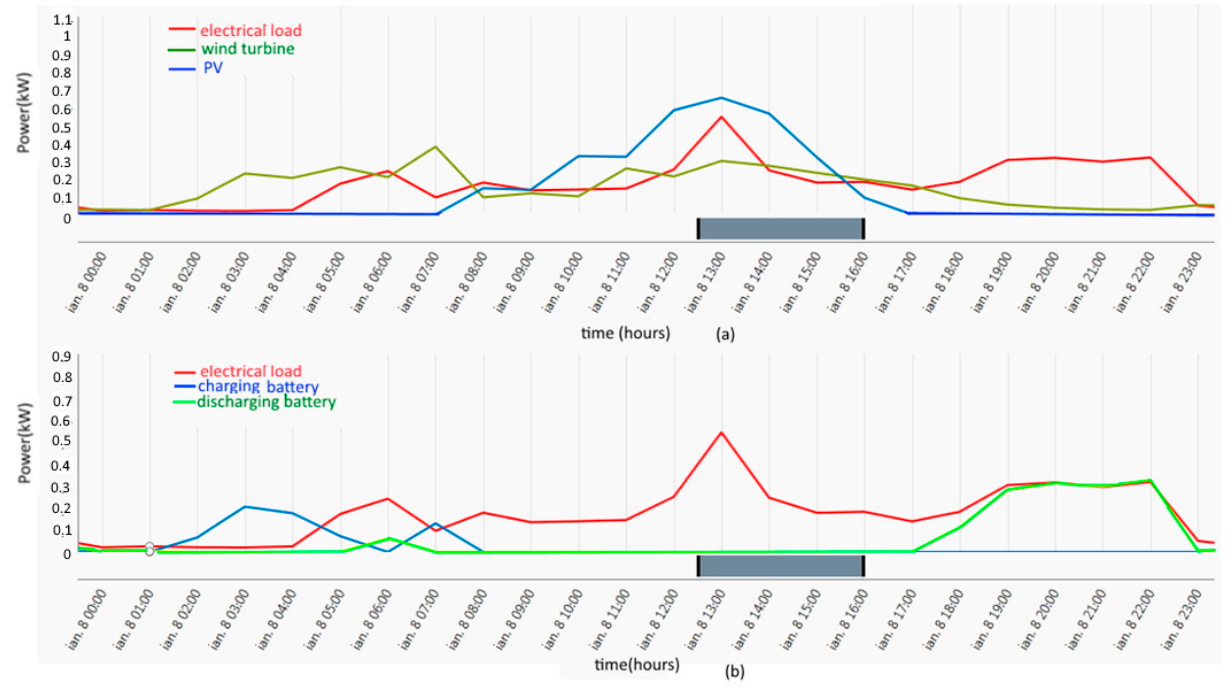
Figure 7. The waveforms for the HOMER simulator: ( a ) The waveforms of 8 January for the hybrid system, ( b ) the waveforms for charging and discharging the battery.